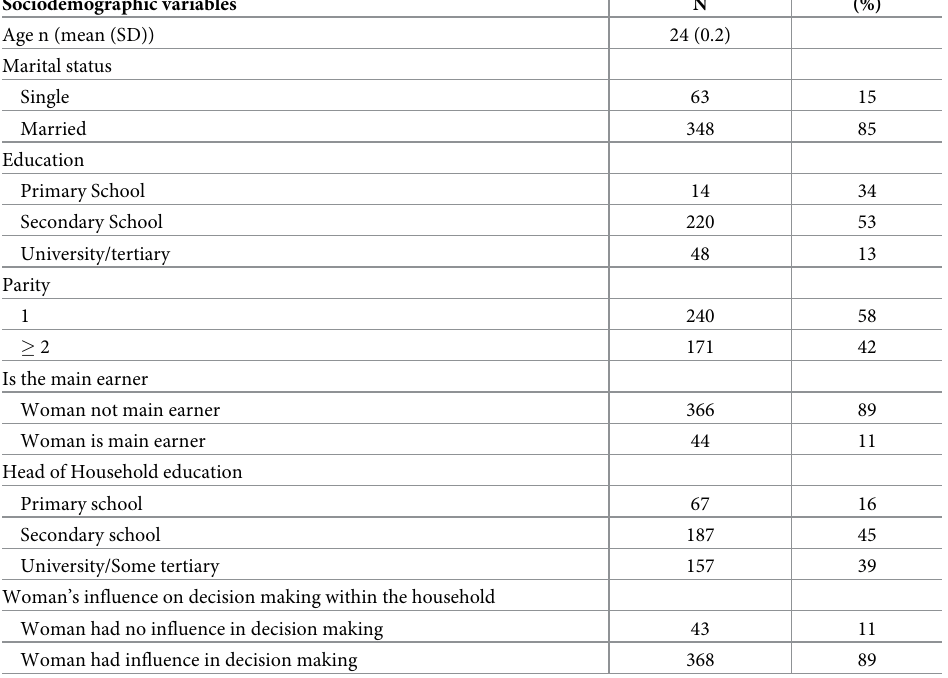
Table 2. Sociodemographic characteristics of the women in a peri-urban setting who were administered for DCE survey (N = 411). Sociodemographic